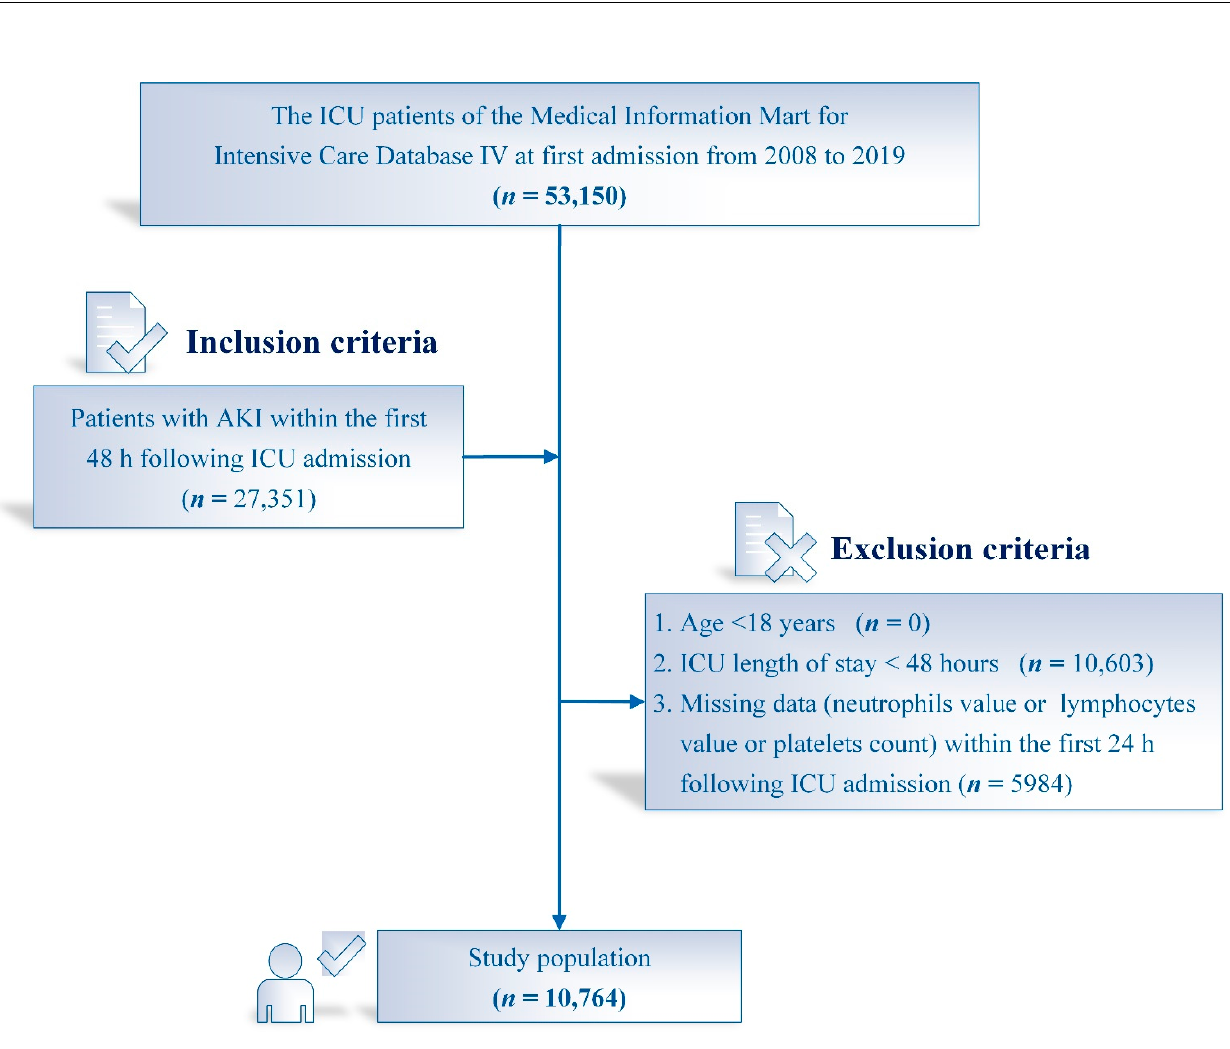
Figure 1. Flowchart of patient selection. n , Number; ICU, Intensive care unit; AKI, Acute kidney injury.